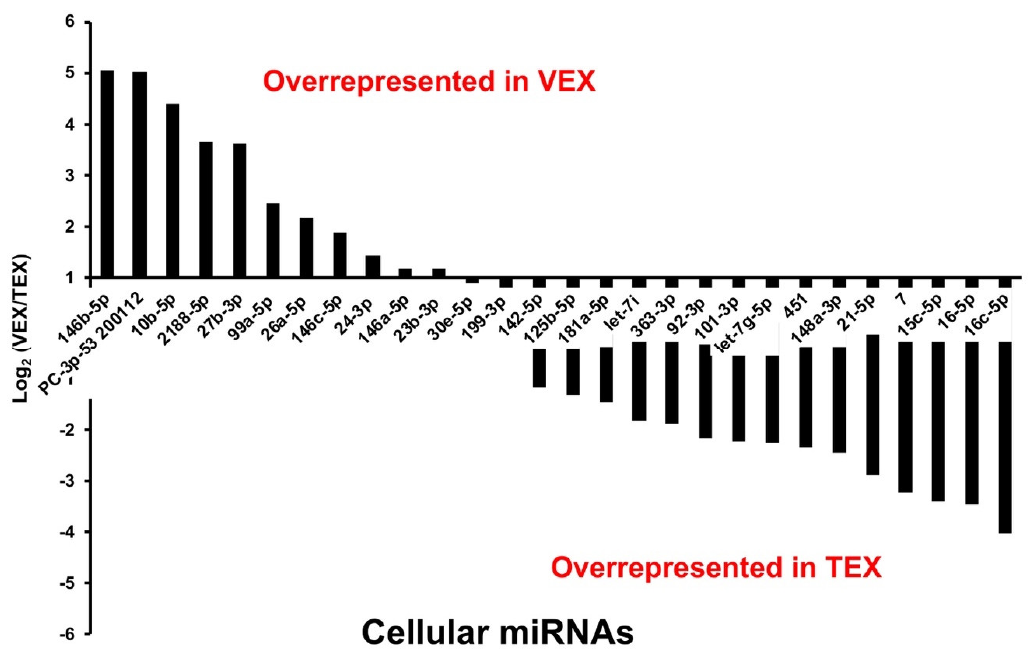
Figure 4. Exosomal cellular miRNAs of different abundance in VEX and TEX. The bar graph above shows a comparison of the Log 2 (PVL/TBL) of miRNA mean read number, where PVL are VEX from vaccinated and protected leghorns, and TBL are TEX from inoculated shedder leghorns. Those to the left are significantly over-represented in VEX, those to the right are significantly over-represented in TEX ( p < 0.01). Table 2. Gallus miRNA read counts and miRNA abundance in leghorn VEX and TEX.